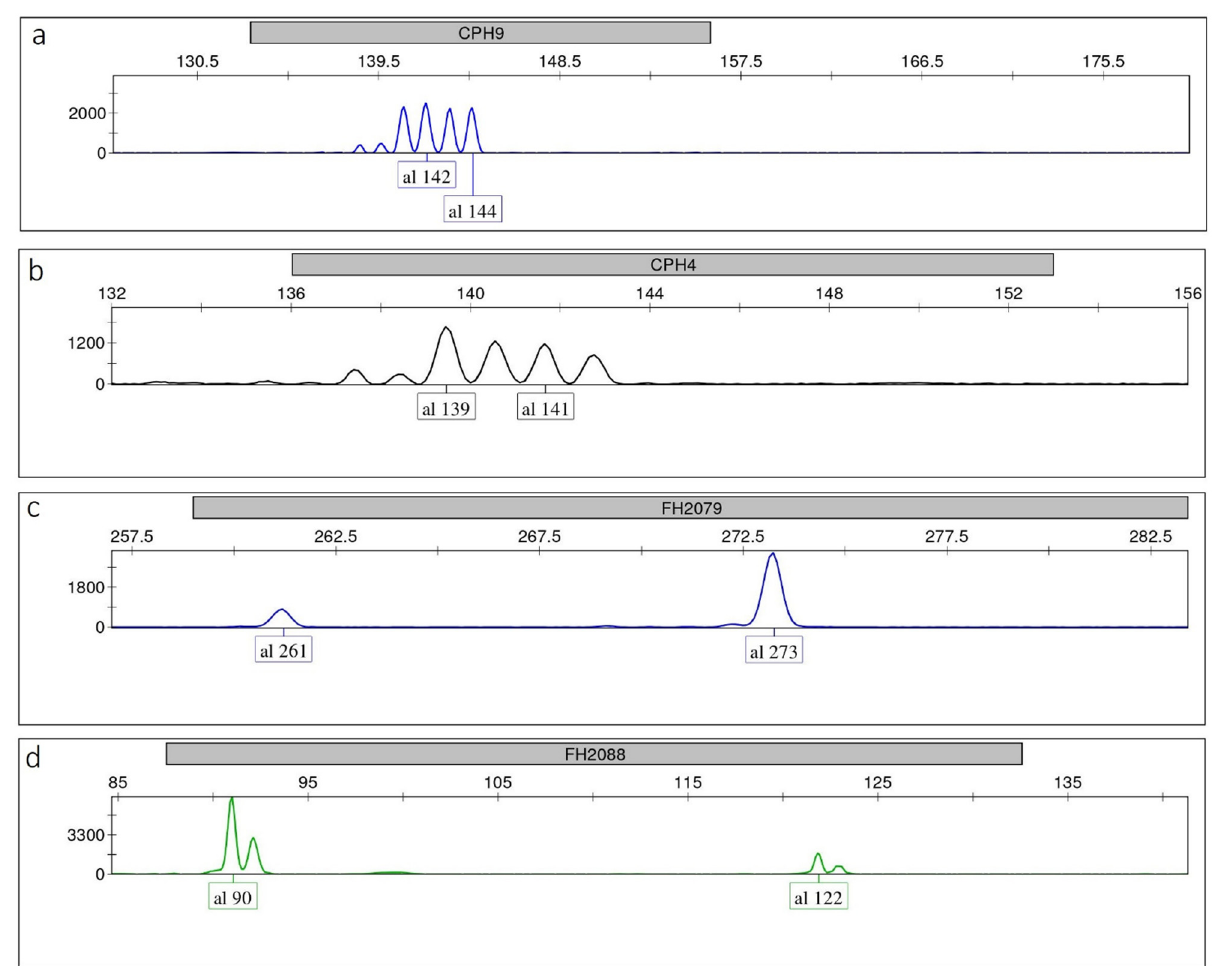
Figure 2. Single-locus electropherograms in heterozygotes showing: ( a ) CPH9—alleles differing in size by 2 bp with backstutters that are as high as the true alleles; ( b ) CPH4—alleles differing in size by 2 bp with plusA bands that reach up to 70–80% of the true alleles; ( c ) FH2079—severe peak imbalance due to primer binding site mutation in one allele; ( d ) FH2088—competition of the smallest allele for best